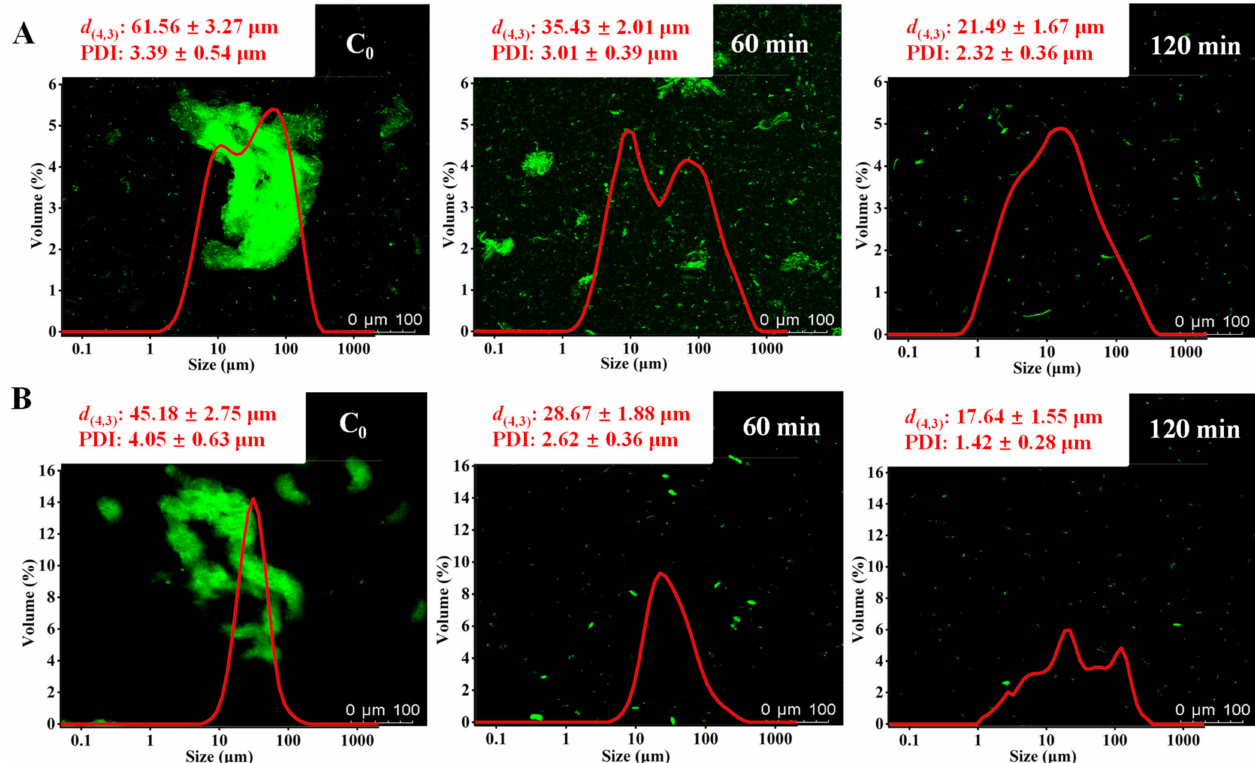
Figure 6. Confocal laser scanning microscopy (CLSM) micrographs and particle distribution of myofibrillar ( A ) and sarcoplasmic proteins ( B ) treated with the S. xylosus A2 protease. d (4,3) and PDI represent the volume average particle size and polydispersity index,